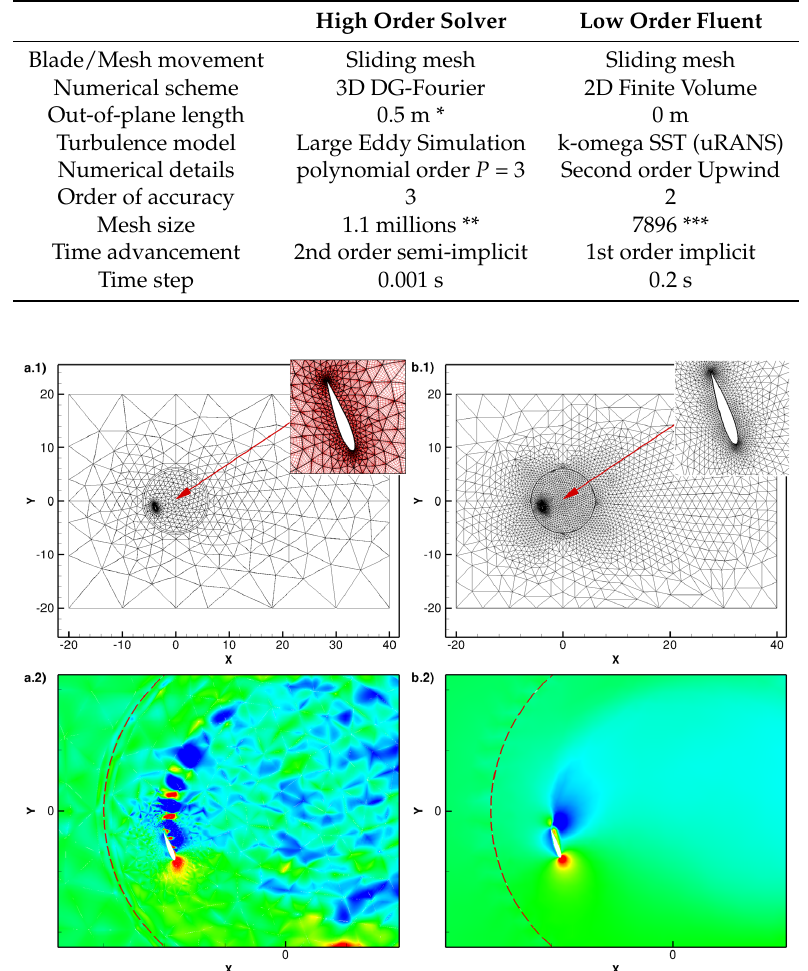
Figure 1. Vertical axis turbine flow fields: ( a.1 ) high order Discontinuous Galerkin mesh with P = 3 (high order polynomial nodes are shown in red); ( b.1 ) low order mesh; ( a.2 ) high order DG numerical solution (LES) and ( b.2 ) low order numerical solution (uRANS). Contours show streamwise velocity ( u x ) with 10 levels from 0 to 0.2. Table 2. Vertical axis turbine conditions. All in international metric system. TSR = ω D /2 U denotes (cid:112) ( ω D /2 ) 2 + U 2 is the Reynolds number based on the chord and rotating the tip-speed ratio, Re c = c ν speed whilst Re D = DU is based on the turbine diameter and free stream velocity . ν Blade Turb. Length Stream Rot. Tip Speed